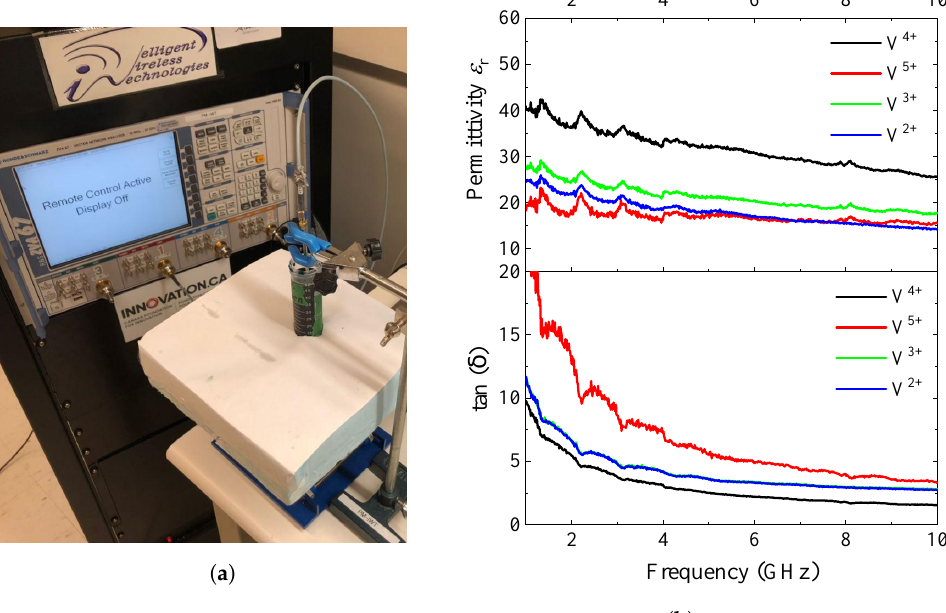
Figure 11. ( a ) Dielectric probe test setup, ( b ) Dielectric probe measurement results for permittivity and loss tangent of vanadium electrolytes.